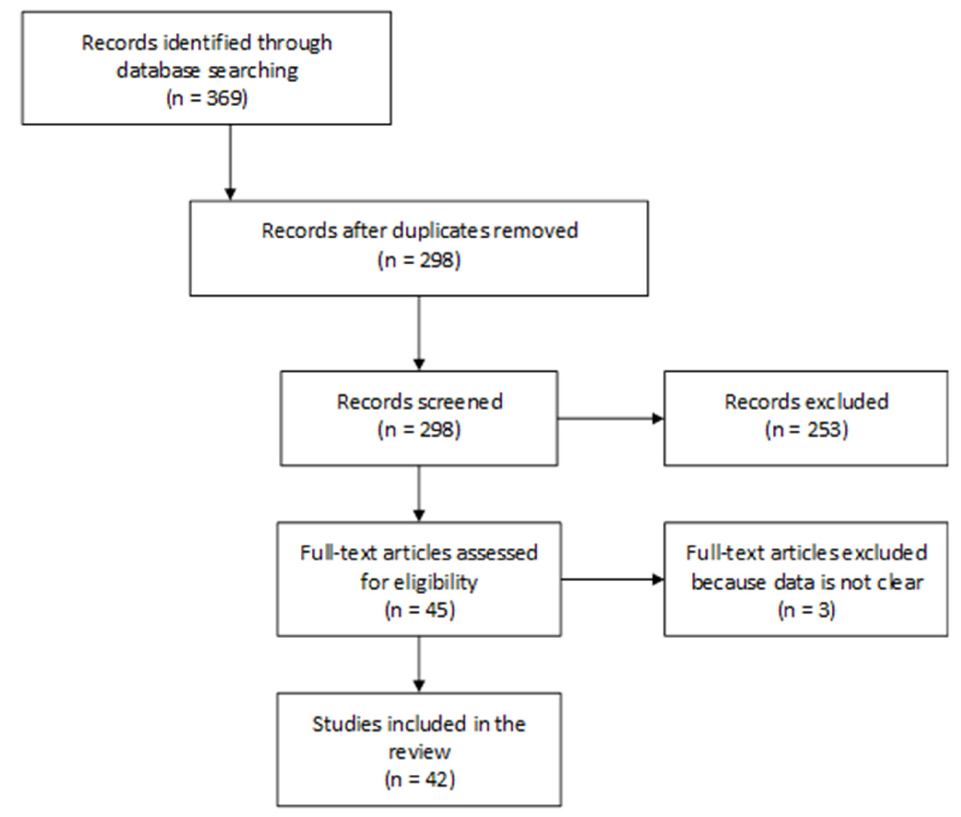
Figure 1. Diagram showing the different phases in the HBM studies selection in this review.